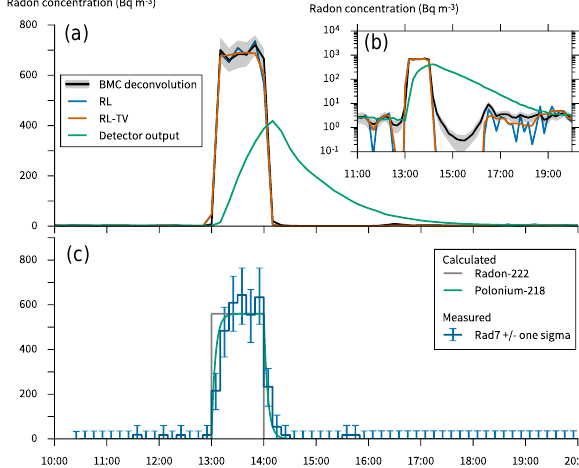
Figure 5. Observed counts and deconvolved output. An elevated concentration of radon was injected into the detector inlet between 13:00 and 14:00LT with counts recorded at 10min intervals. Obser- vations were corrected for the detector response using the Bayesian Monte Carlo (BMC, with the 16th–84th percentile range shaded in grey), Richardson–Lucy (RL), and Richardson–Lucy with total variation regularisation (RL–TV) deconvolution methods. Panel (a) shows the output from the two-filter detector and the reconstructed time series. Panel (b) shows the same data on a log scale to em- phasise the period of low radon concentrations before and after the spike. Panel (c) shows a repeat measurement where the two- filter detector has been substituted for a fast-response radon detec- tor (RAD7, Durridge Company Inc.). The concentration of radon– 222 and polonium–218, computed from the source activity and flow rate, is also shown in (c)